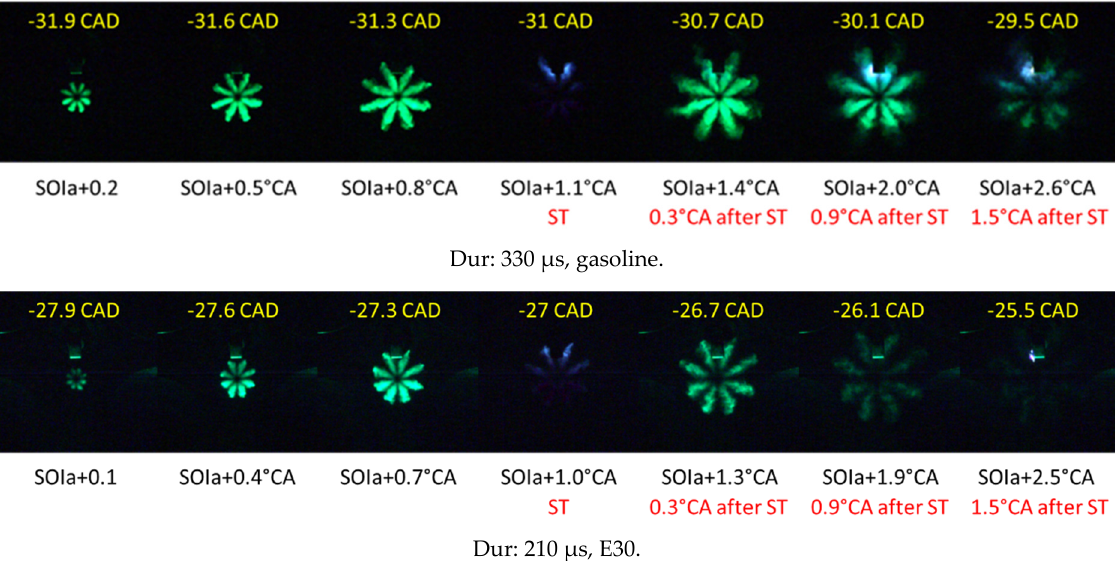
Figure 17. Pilot visualization from the first observable liquid spray until the kernel ignition.